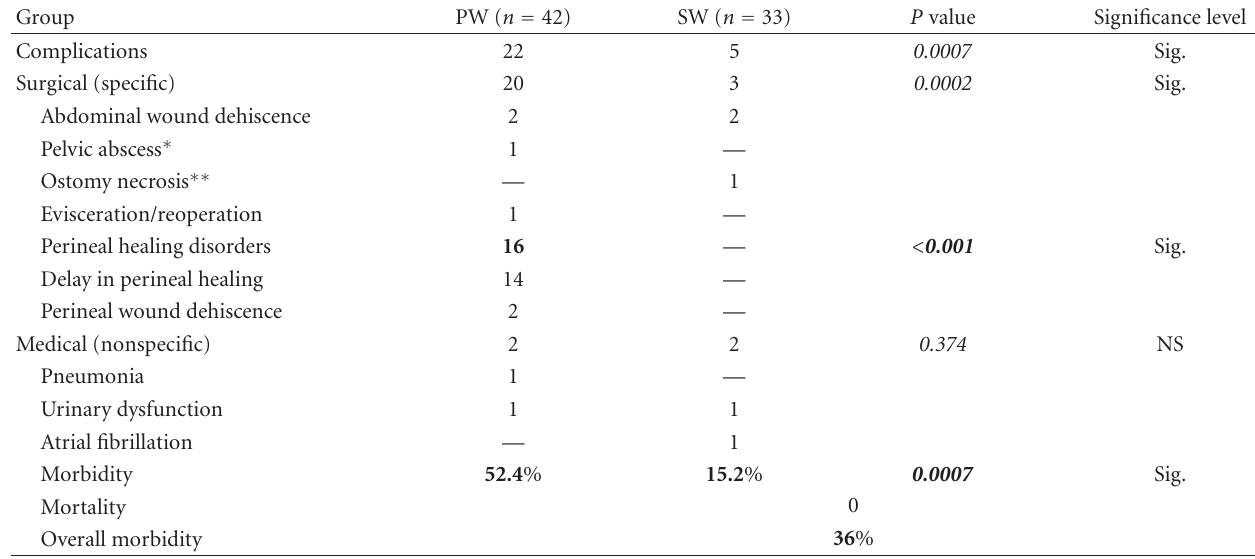
Table 4: Complications, morbidity, and